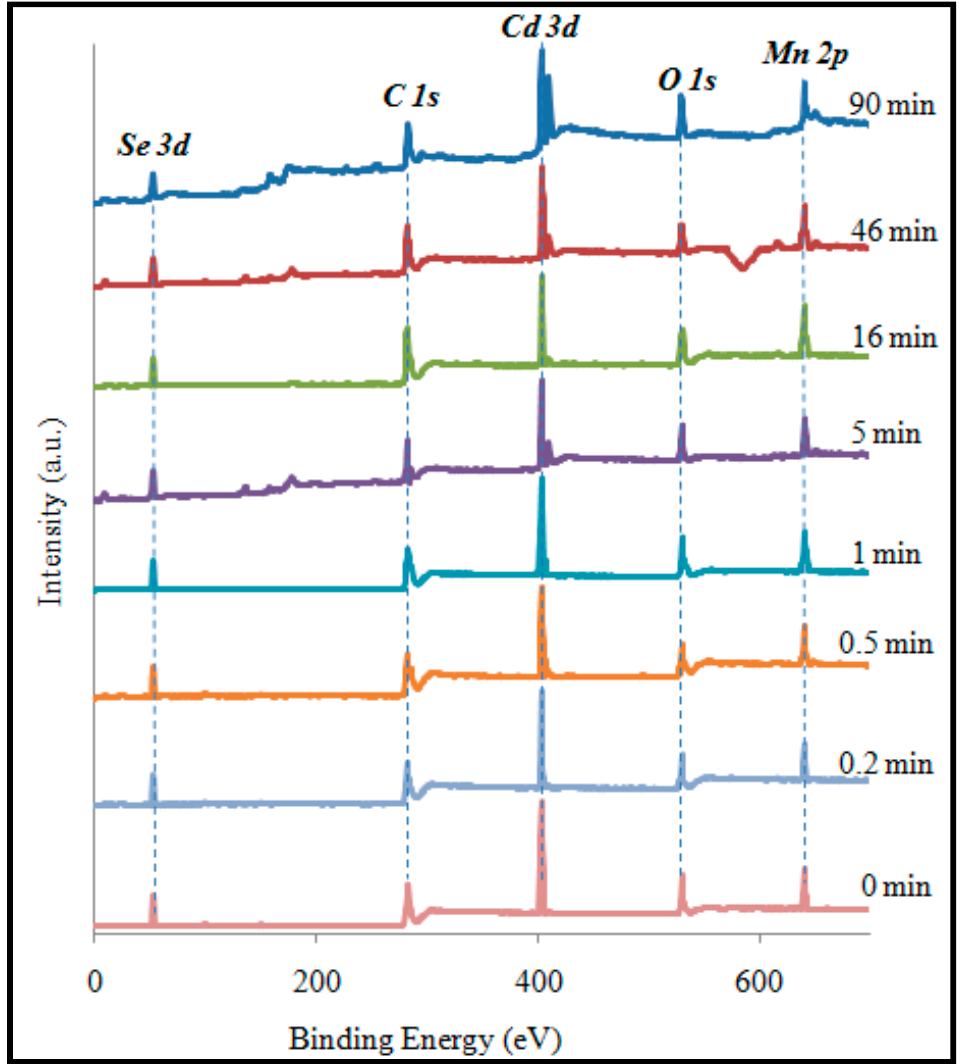
Figure 13. XPS wide scan of Mn-doped CdSe QDs at di ff erent reaction Figure 13 XPS wide scan of Mn-doped CdSe QDs at different reaction times